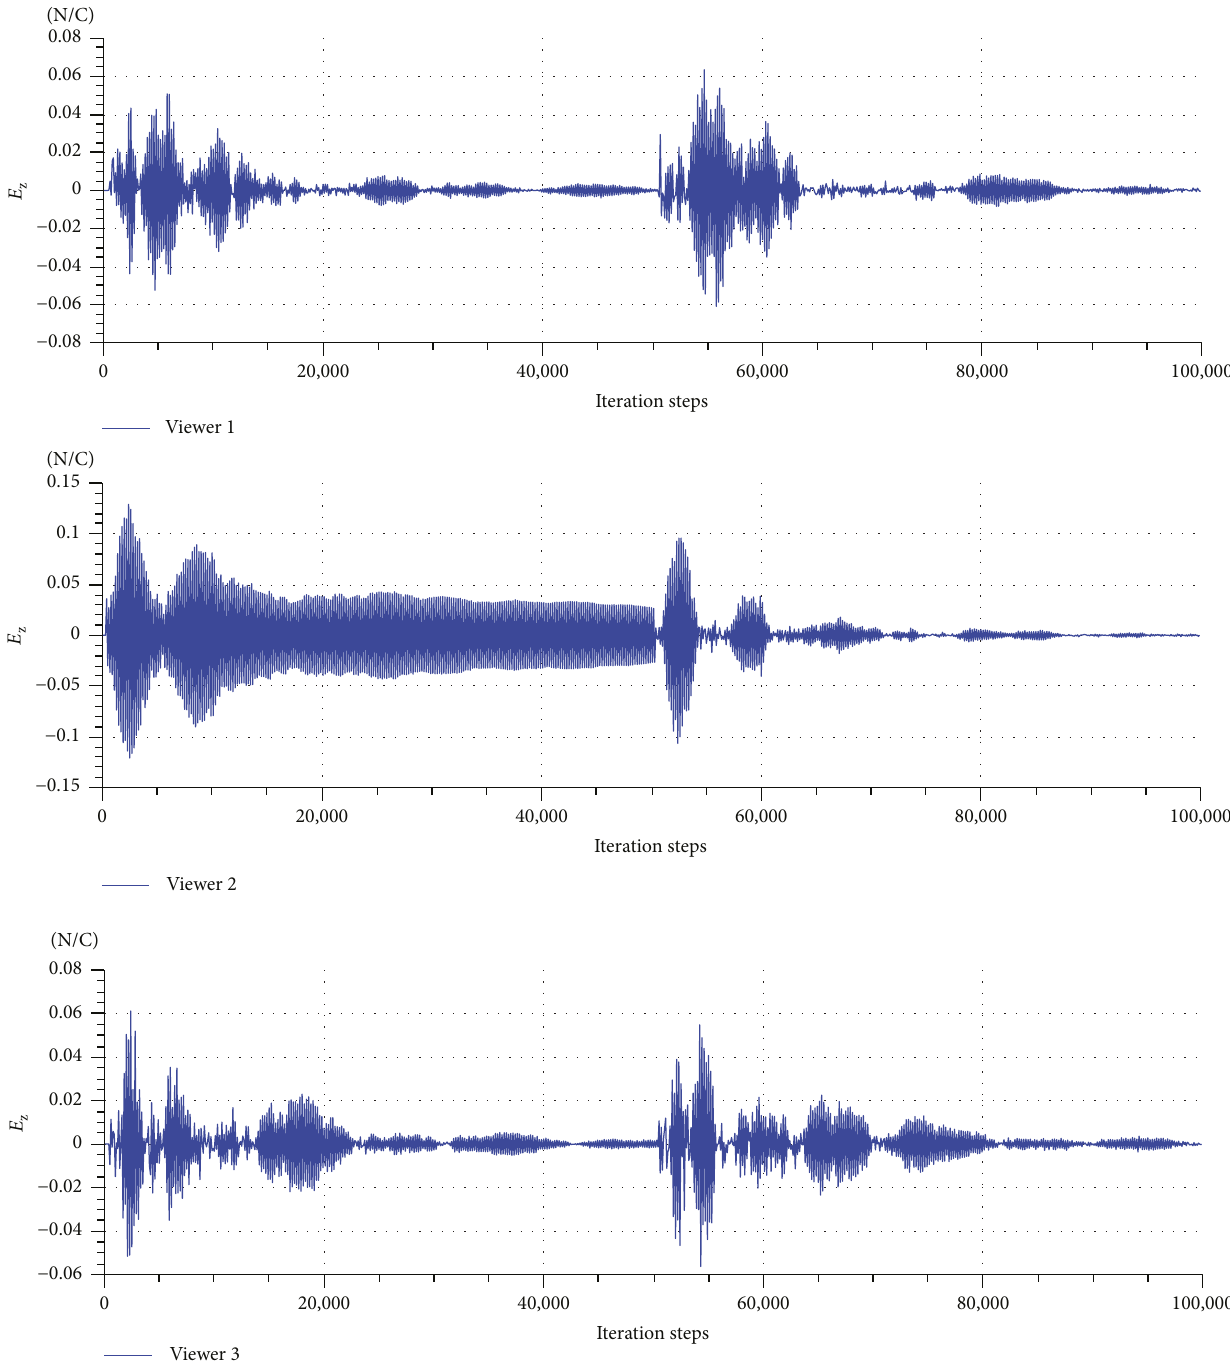
fi rst o ffi z in the viewers of the